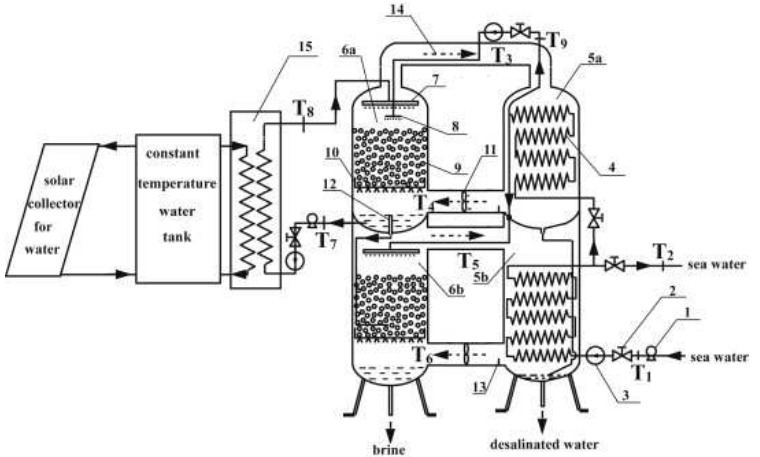
Figure 9. Schematic of two desalination and heat exchanger solar HD desalination systems. Repro- duced with permission from Zehui Chang, Hongfei Zheng, Yingjun Yang, Yuehong Su, Zhanchun Duana, Renewable Energy Journal, published by Elsevier, 2014 [188].